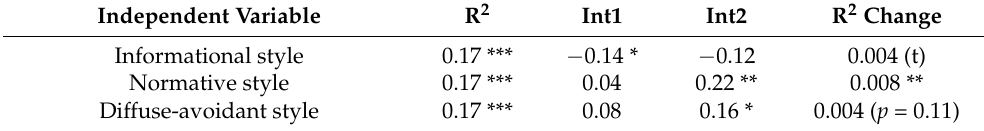
Table 3. Results of the moderation analyses with religiosity as dependent